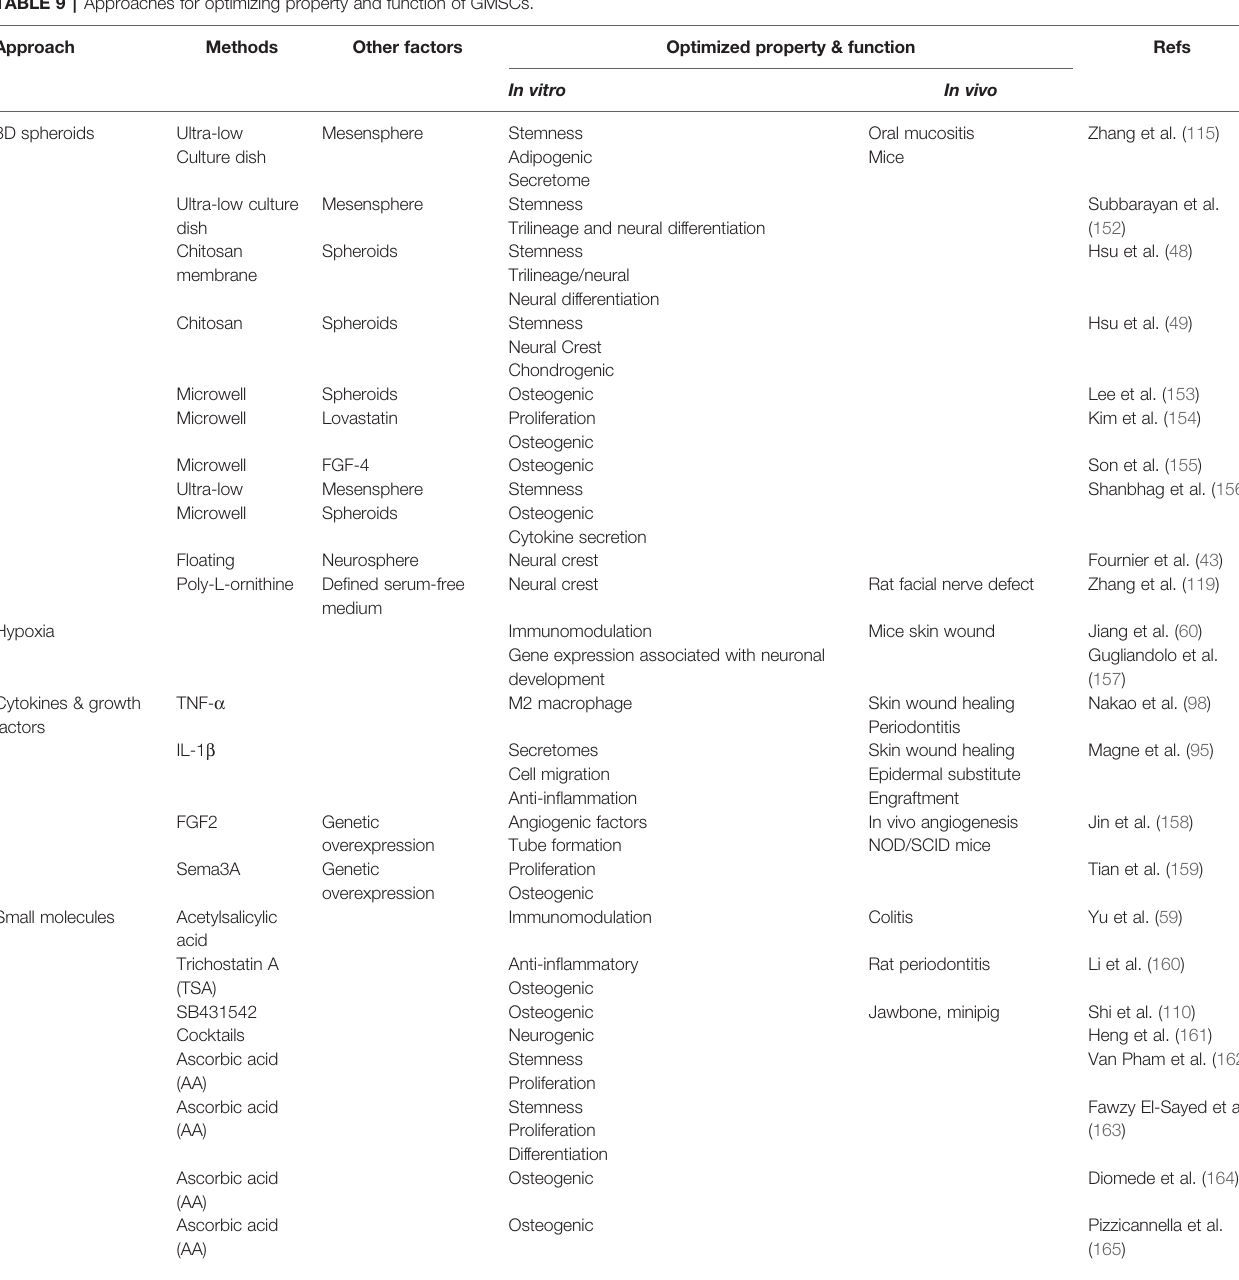
TABLE 9 | Approaches for optimizing property and function of